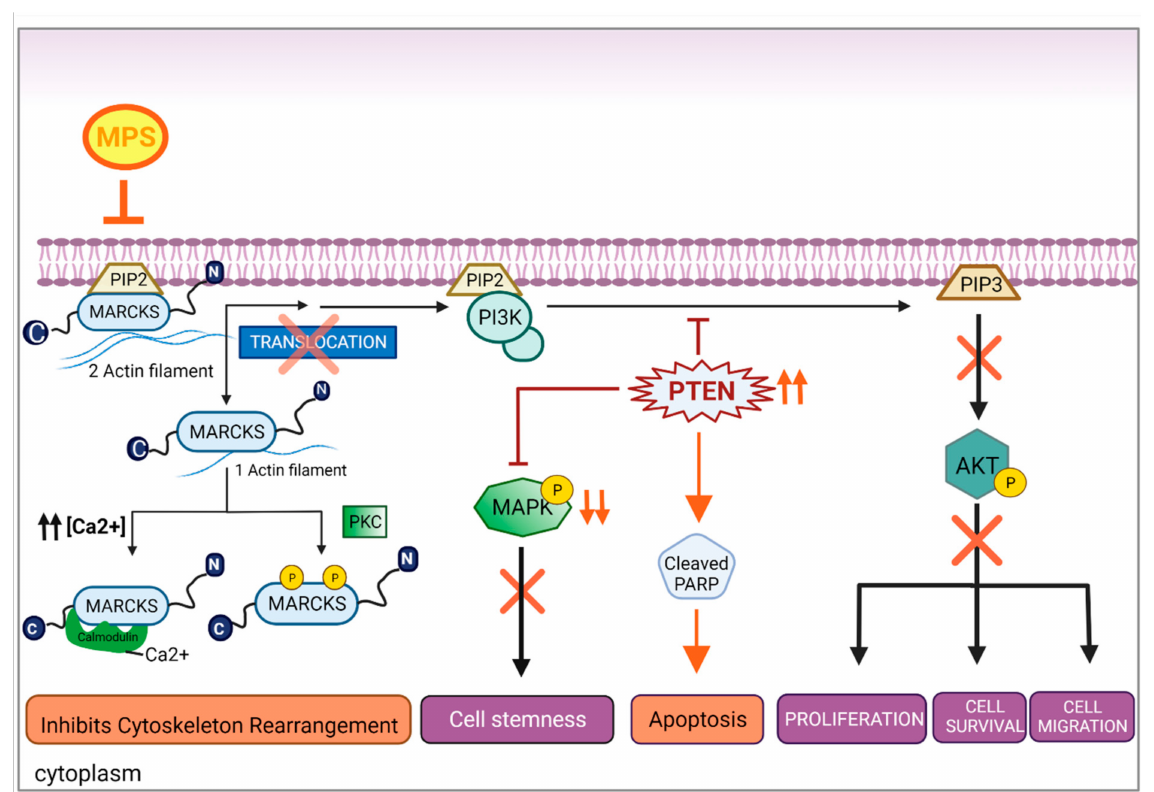
Figure 4. MPS peptide specifically suppressed the activation of MARCKS and regulated PTEN/AKT and MAPK pathways in inflammatory breast cancer cells. MARCKS is involved in various cellular processes, particularly in the cytoskeleton control (by phosphorylation of MARCKS), proliferation, cell motility, and cell survival (by the PI3K/AKT pathway). Exposure of PIP2 on the membrane allows PI3K to phosphorylate it into PIP3, activating AKT-mediated signaling. However, this pathway is regulated by various factors, including PTEN. Our representative figure explains in part the mechanistic role of MPS peptide in IBC cells explaining how MARCKS inhibition subsequently inhibited AKT phosphorylation (represented by an orange cross and down arrows) and, more importantly, the upregulation of PTEN (represented by anascending arrows), leading to apoptosis and the downregulation of the MAPK pathway (represented by an orange cross and down arrows). These found regulations potentially led to the cytoskeleton rearrangement, proliferation, cell motility, tumor stemness inhibition, and apoptosis